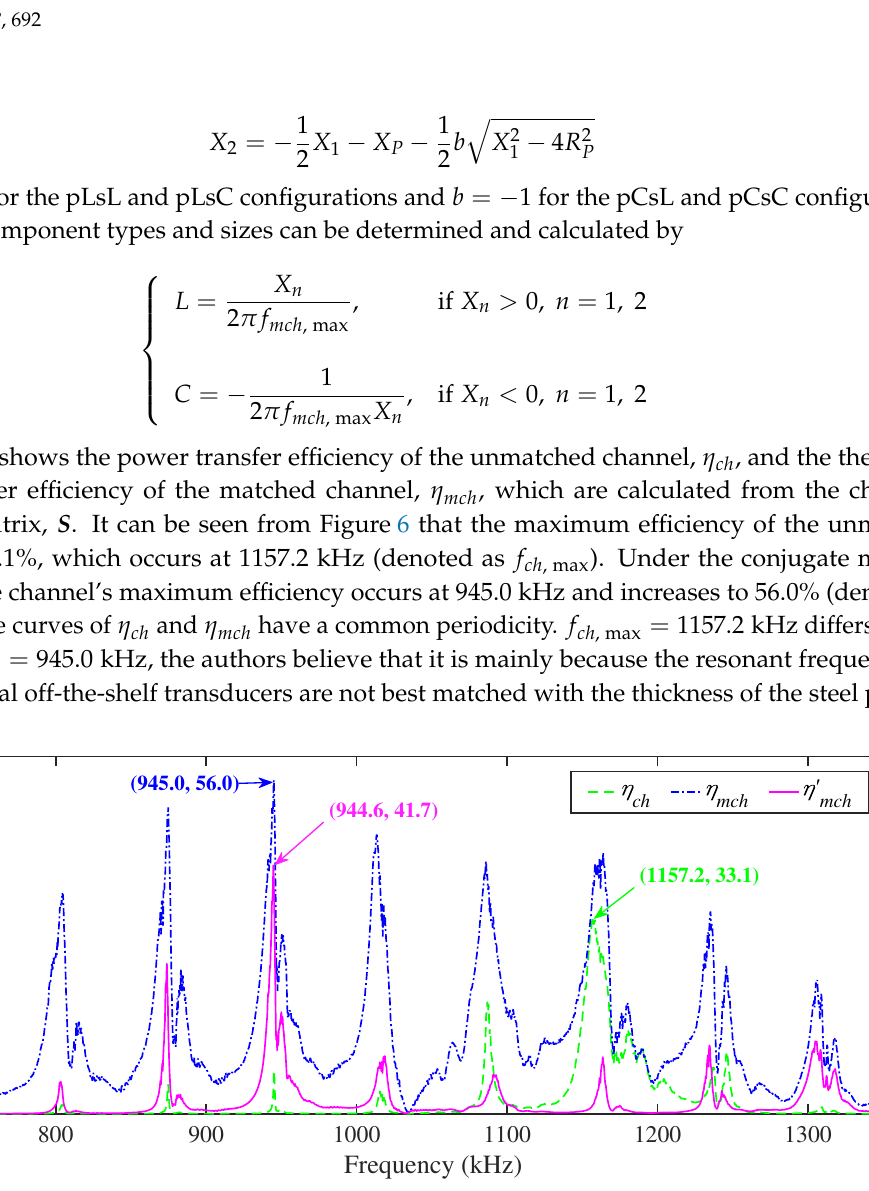
Figure 6. Power transfer efficiencies of the unmatched and matched